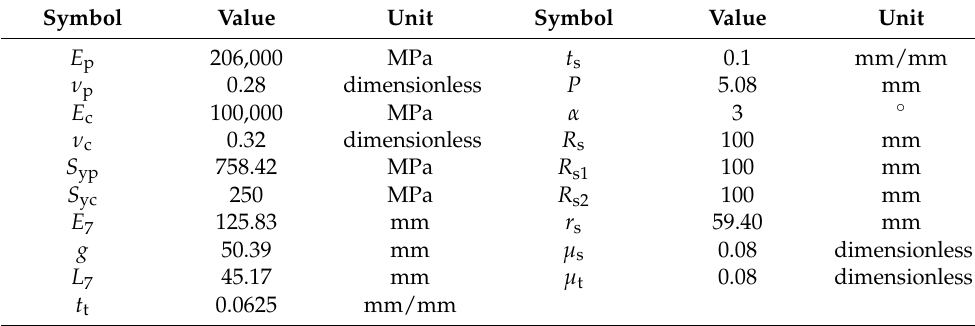
Table 1. The basic parameters for sphere-type premium connection.